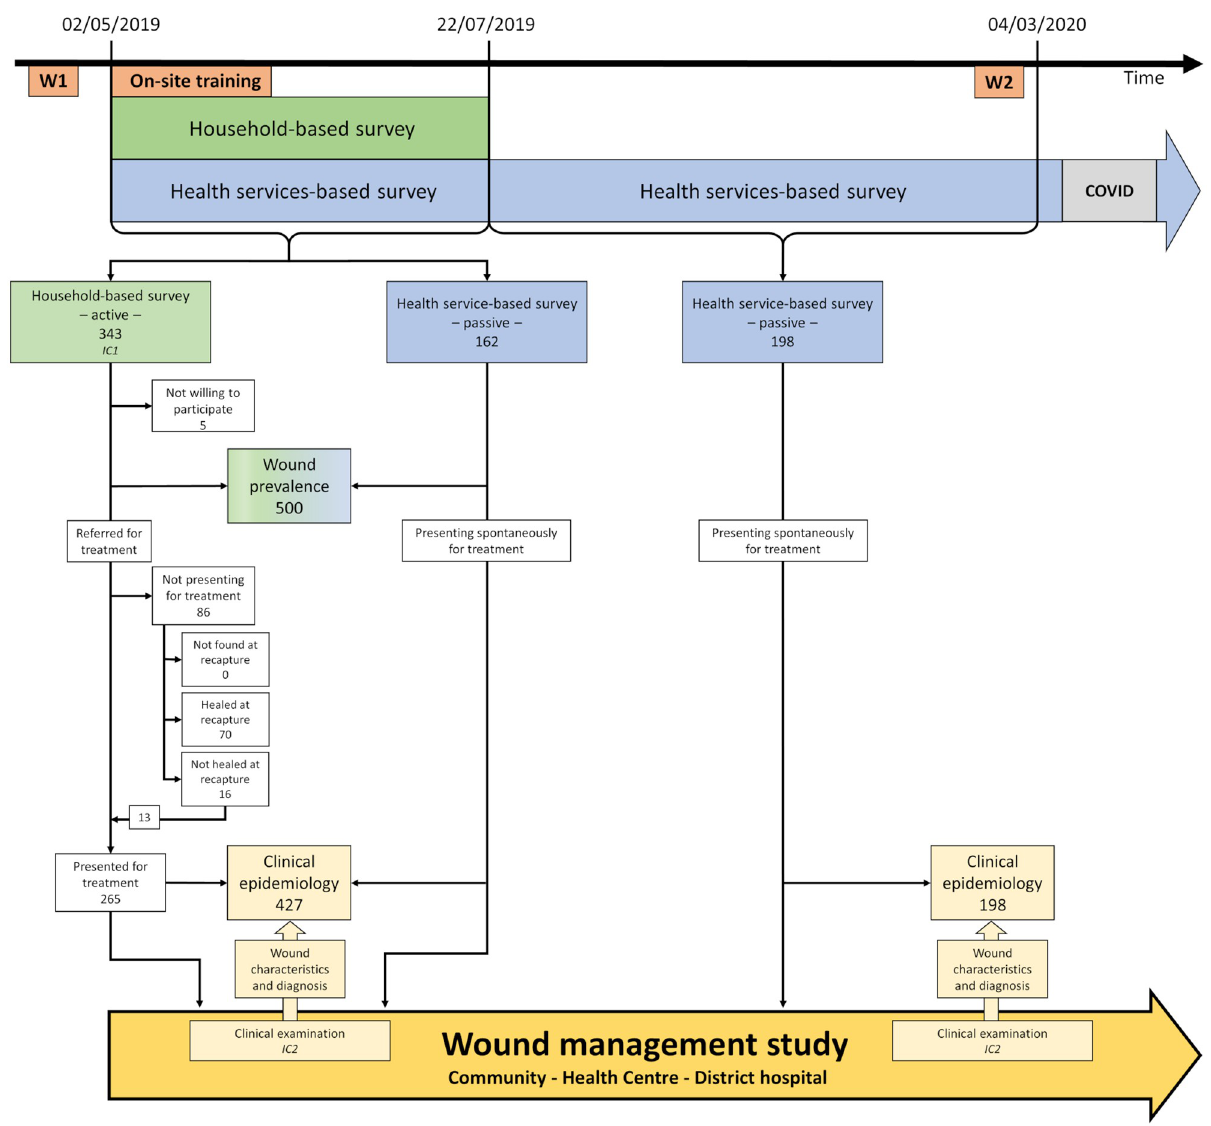
Fig 2. Enrolment of wound events into the wound management study during household- and health services-based surveys. Wound event was defined as an injury (e.g. mechanical trauma, burn, animal bite) or a specific pathology (e.g. BU, yaws) leading to one or multiple wounds. Wounds enrolled on the same date and attributed to the same aetiology were considered as one wound event. Specific aetiologies, such as BU or yaws, that could lead to multiple wounds over time were considered a single wound event. For details see [13].